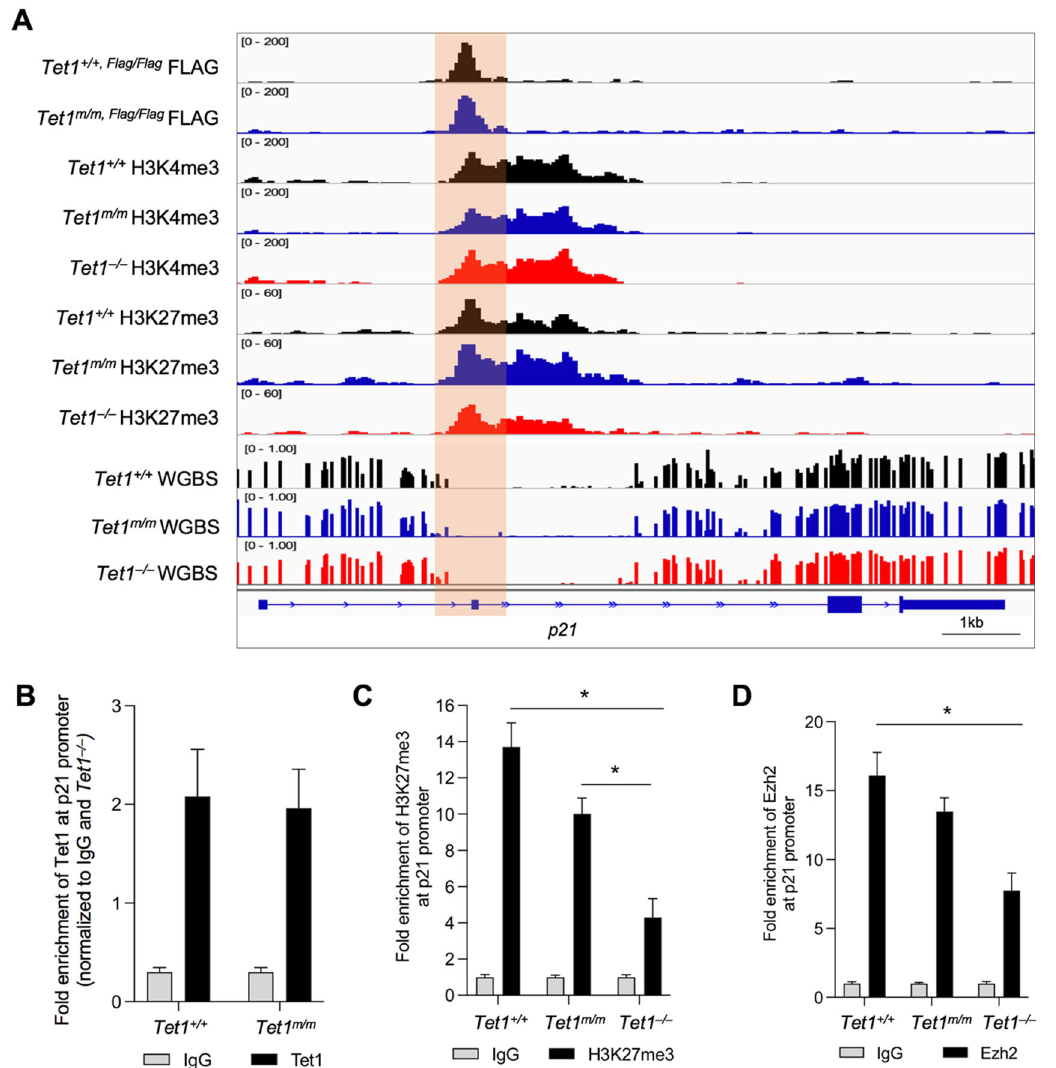
Figure 3. Tet1 silences p21 in mESCs by promoting Ezh2 recruitment to the p21 promoter for H3K27 trimethylation. ( A ) Genome browser tracks displaying co-occupancy of wild type and catalytic mutant Tet1 with bivalent marks (H3K4me3 and H3K27me3) and DNA hypomethylated regions at the p21 locus in mESCs of indicated genotypes using our previously published CUT&Tag and WGBS data in Tet1 +/+ , Tet1 m / m and Tet1 − / − mESCs (see Methods). Note that the levels of H3K27me3 are reduced in Tet1 − / − ESCs whereas DNA methylation levels are unaffected at the Tet1-bound p21 locus. ( B – D ) Quantification of enrichment of Tet1 ( B ), H3K27me3 ( C ) and Ezh2 ( D ) at the p21 promoter region in Tet1 +/+ , Tet1 m / m and Tet1 − / − ESCs (data normalized to 10% input control and IgG). Three replicates of each genotype were used. Note the significant reduction in the levels of H3K27me3 and Ezh2 at the p21 promoter in Tet1 − / − mESCs. In all panels, data are presented as ± SEM; statistically significant * p < 0.05 (two ‐ way ANOVA test).